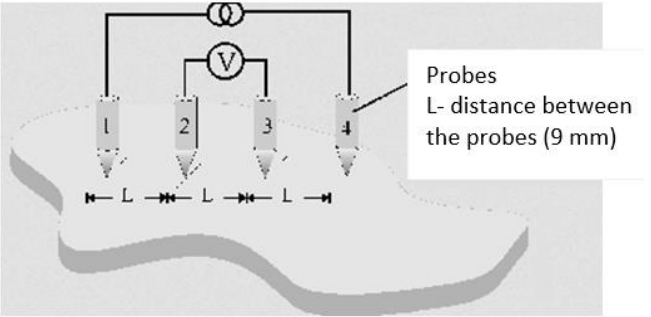
Figure 1. Schematic layout of four electrodes for measurements of surface resistance of electrically- conductive paths by four points method.